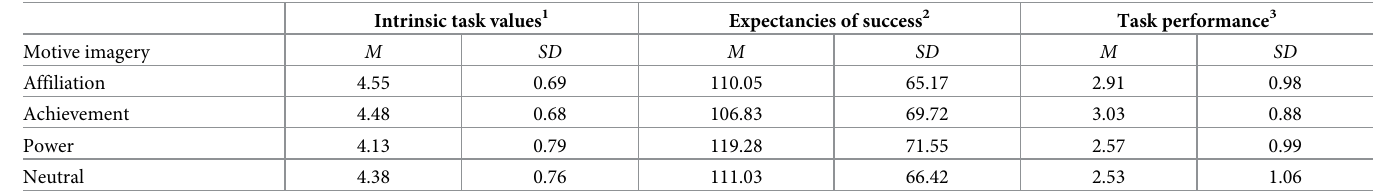
Table 2. Means and standard deviations for intrinsic task values and expectancies of success and performance in neutral tasks, and tasks related to affiliation, achievement, and power in Experiment 1.